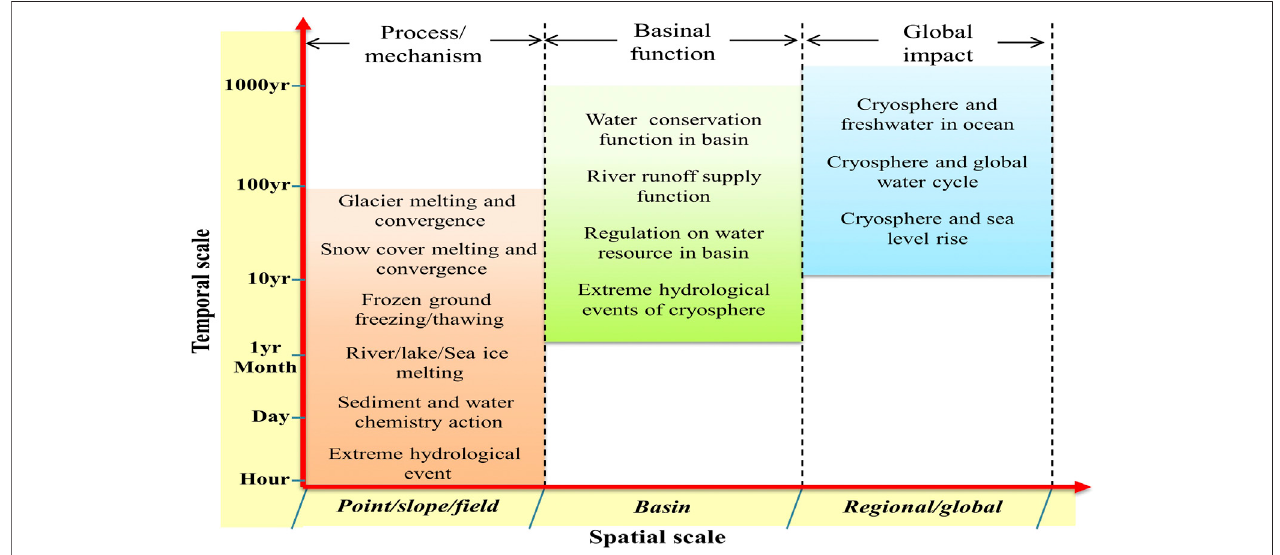
FIGURE 4 | Difference of main research contents of cryohydrology at the temporal (hour, day, month, year, and more than 1,000 years) and spatial (point/slope/ fi eld, basin, and region/global) scales.